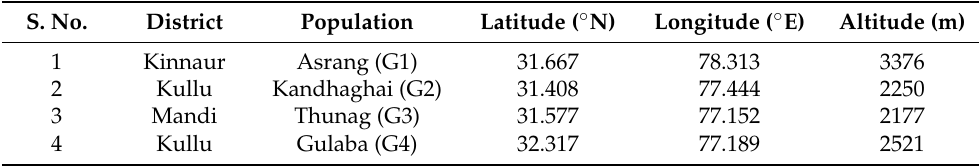
Table 5. Geographical description of four diverse genotypes of A. glauca from Himachal Pradesh. S.